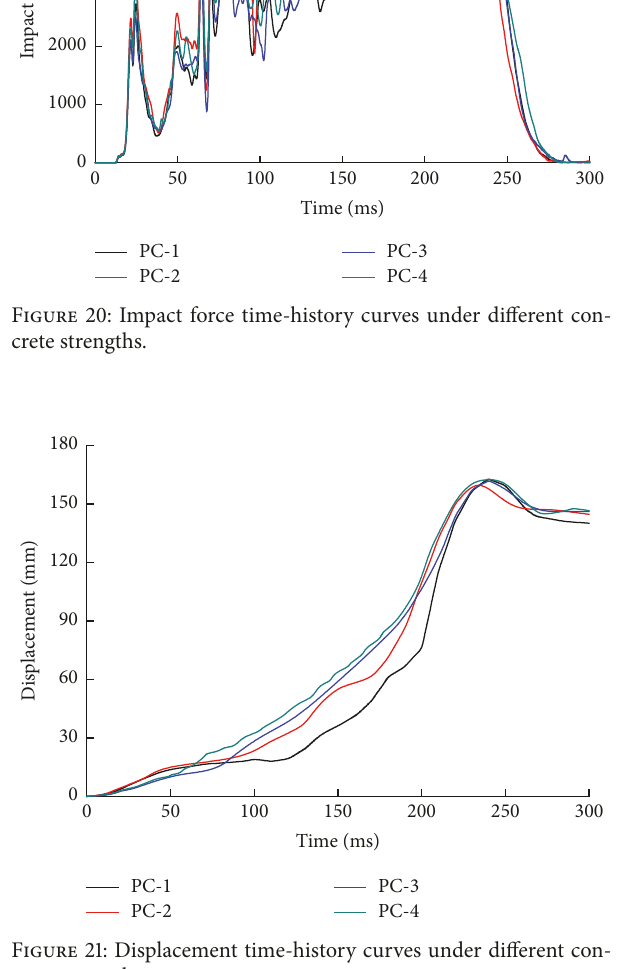
Figure 23: Displacement time-history curves under different steel